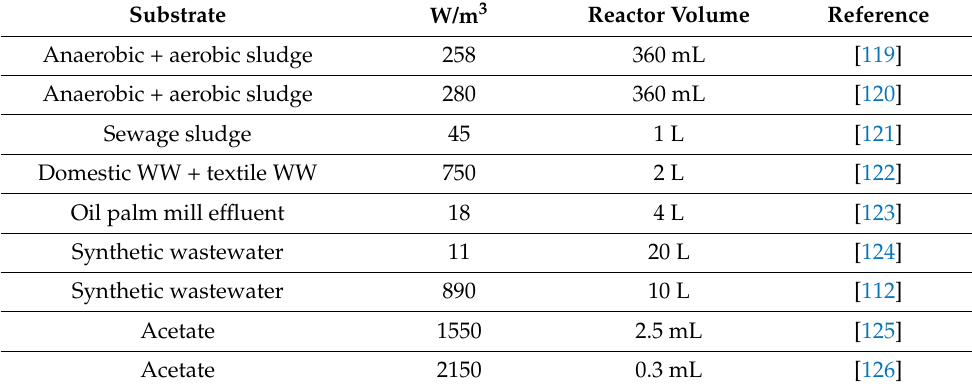
Table 2. Power production in MFCs above the 10 W/m 3 limit.